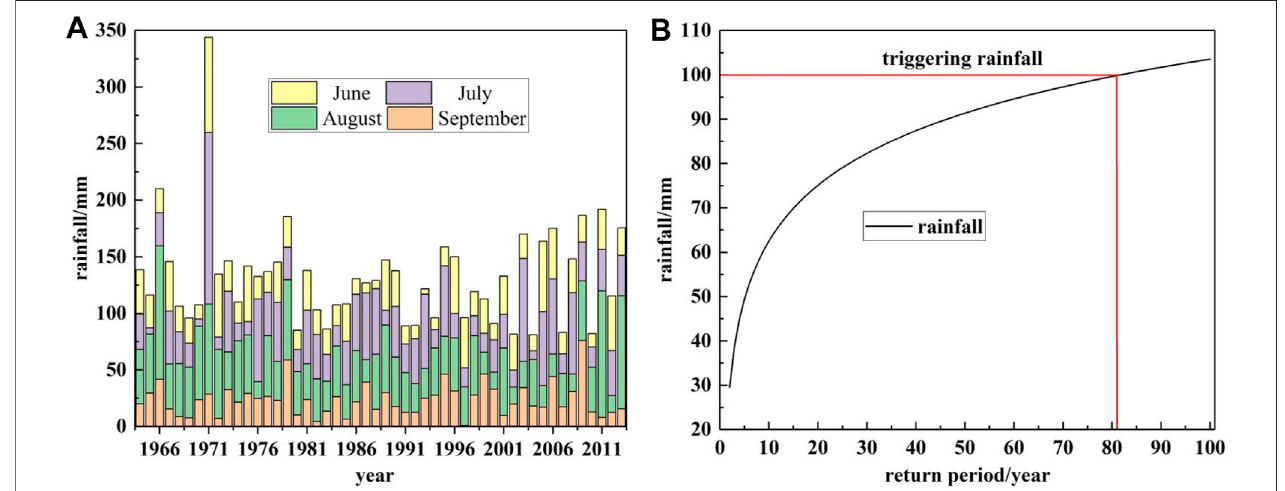
FIGURE12| Returnperiod ofthetriggeringrainfallevent: (A) dailyrainfallpeaksineveryrainyseasonfrom1964to2013and (B) rainfallvaluesvs.thereturnperiod of the study area.